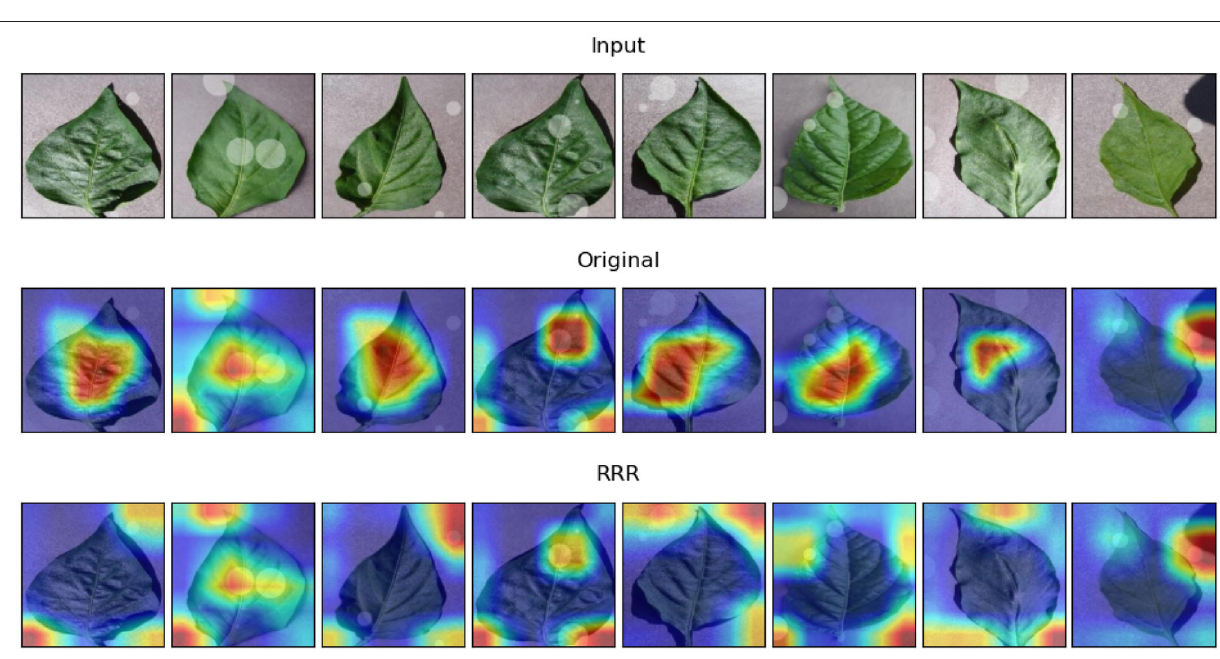
FIGURE 7 | Examples of model explanations for the first task. The three rows display the input image, original explanation, and the explanation with the consideration of expertise. The pixels outside the added circles of each input are labeled as the real masks. A warmer color in the explanation indicates a higher contribution value, denoting a more important pixel for the classification task.